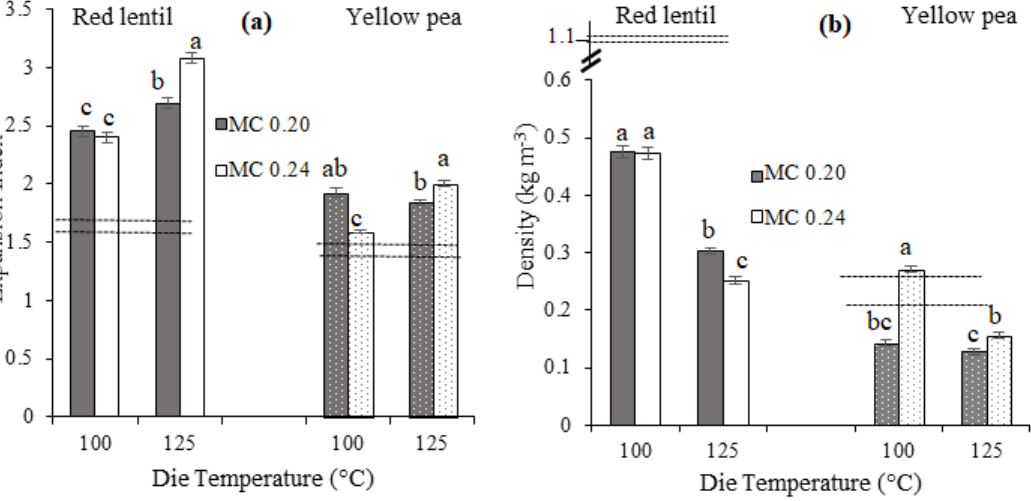
Figure 1. Expansion index ( a ) and density ( b ) of third-generation red lentil and yellow pea products with moisture contents of 0.20 (MC 0.20) and 0.24 (MC 0.24) kg water per kg dry flour. Dashed lines refer to the minimum and maximum expansion index ( a ) and density ( b ) of second-generation products. Error bars represent ± standard error. For each flour type, expansion index and density values designated with different letters are significantly different ( p ≤ 0.05).